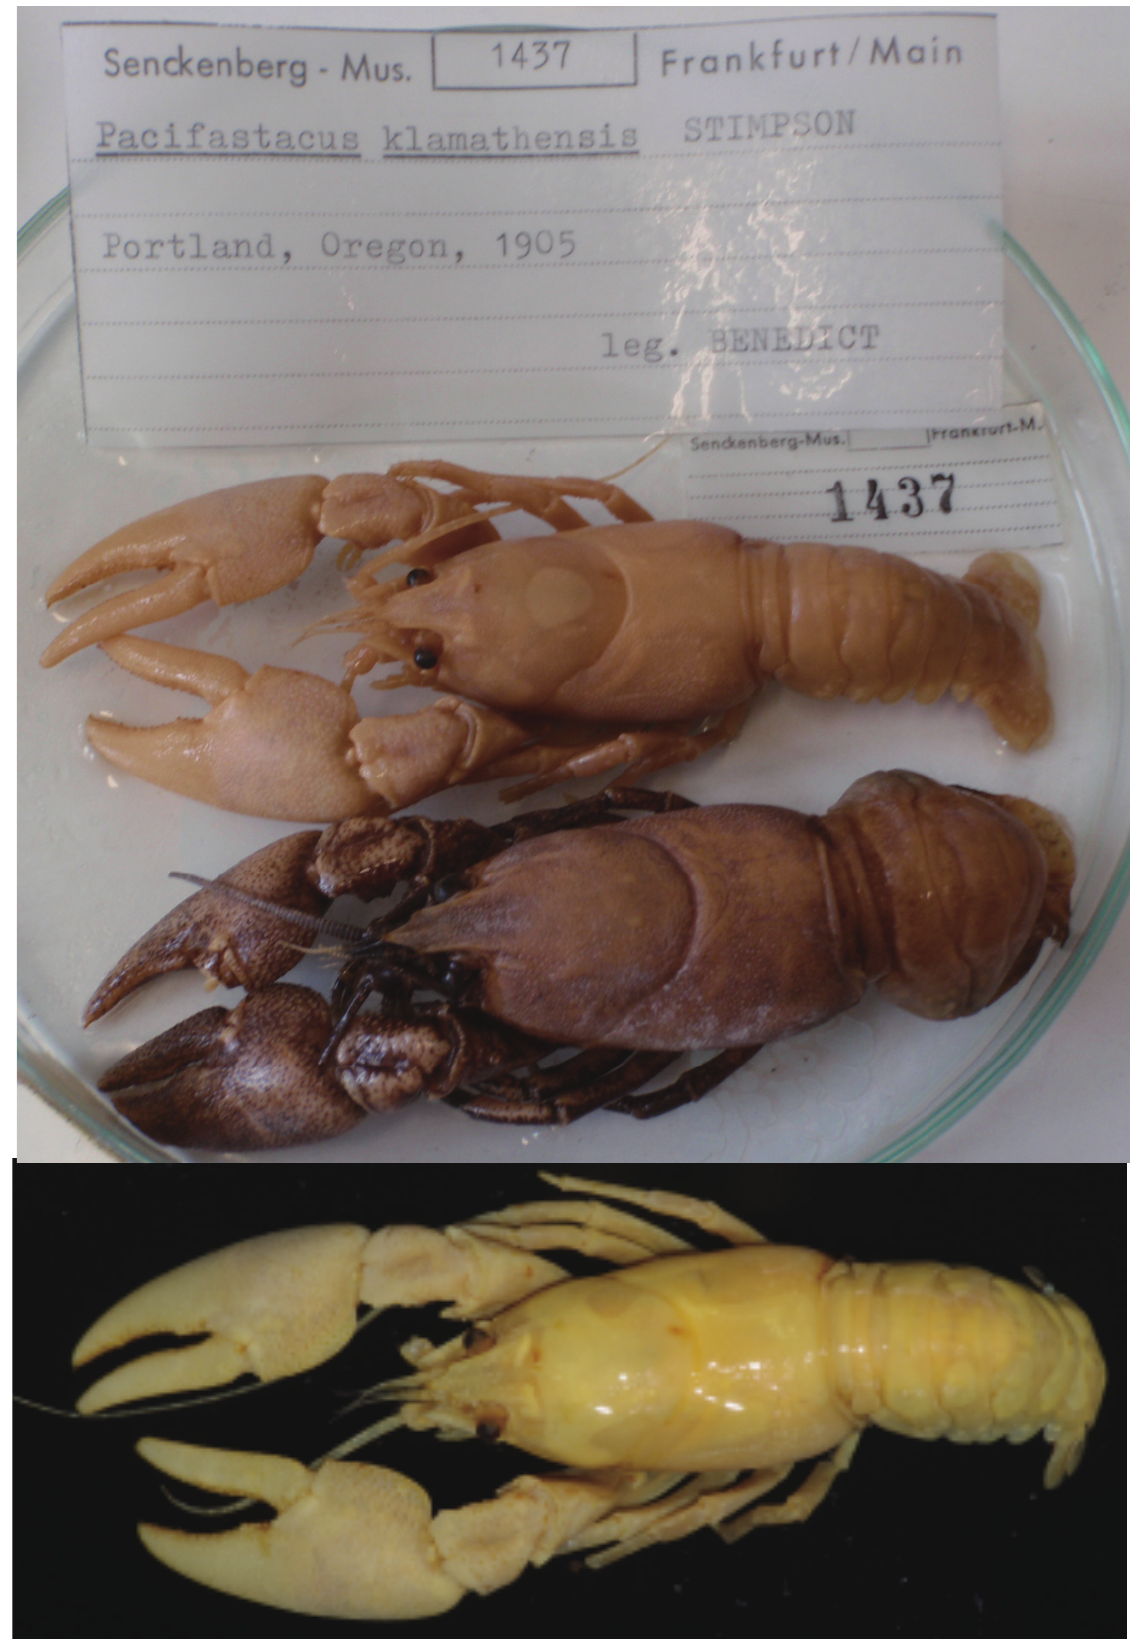
Figure 3. Pacifastacus leniusculus klamathensis (Stimpson, 1857). Lot SMF 1437: current label, male #3, and female (upper); male #3